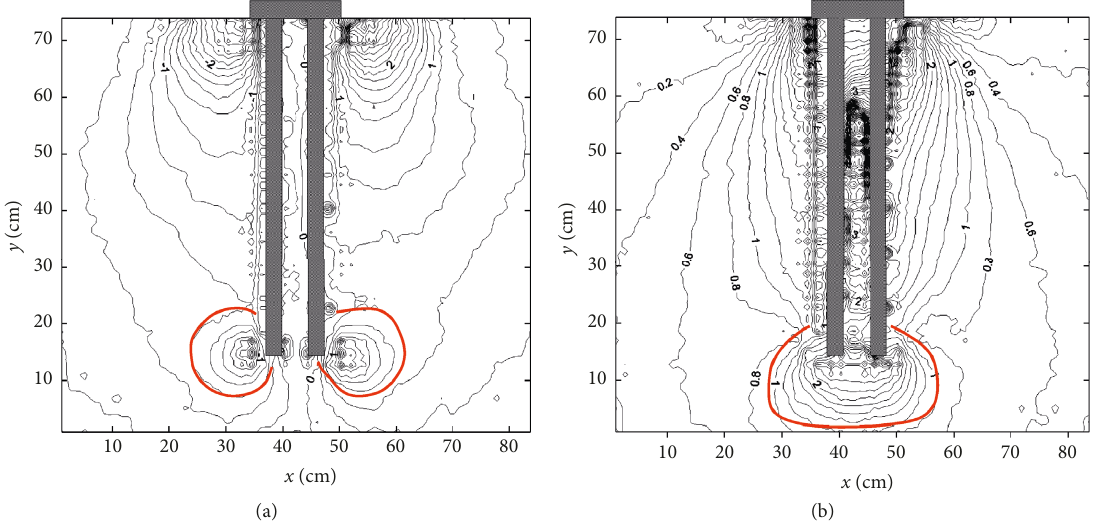
Figure 8: Displacement contour of the pile group with 3 b pile spacing. (a) Horizontal displacement. (b) Vertical